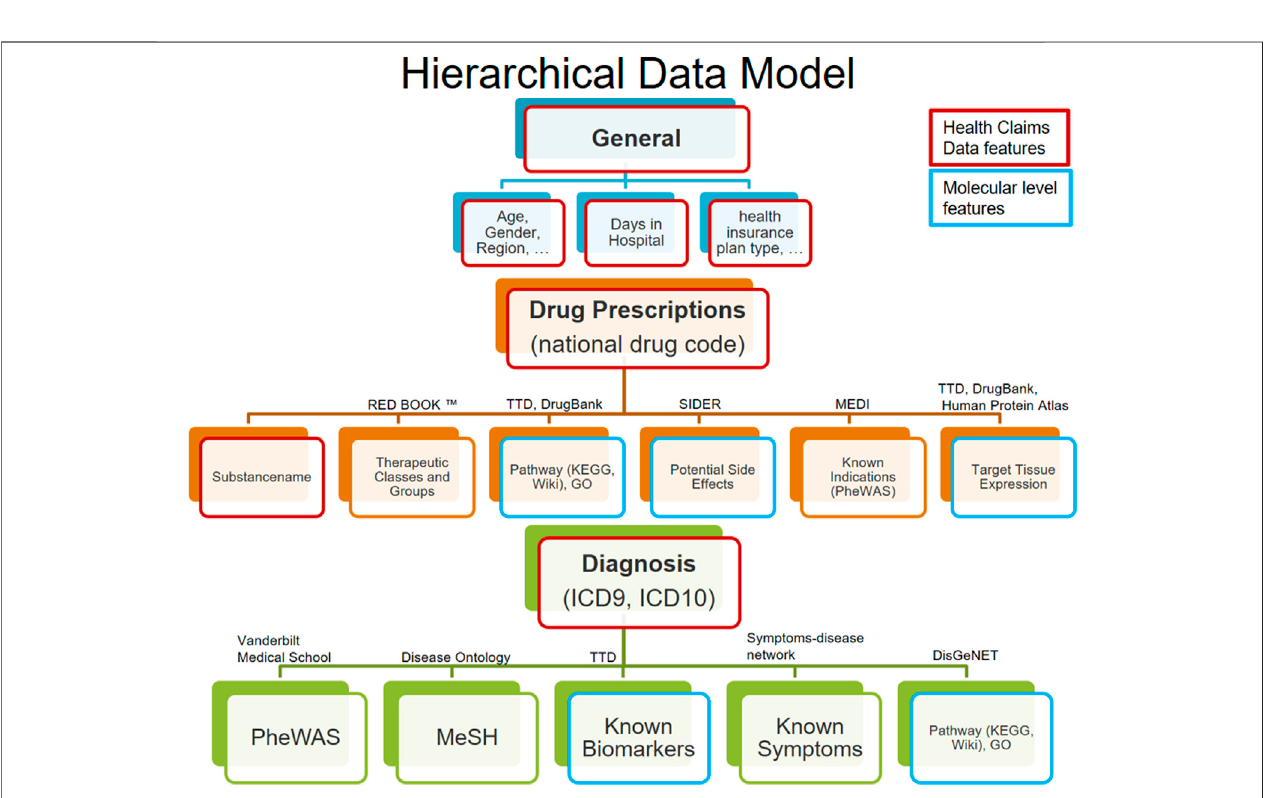
FIGURE 1 | Hierarchical data model structures the data in 3 input domains (general, drug, and diagnosis) and according subdomains. Features retrieved from the claims data are highlighted in red, and all others are augmented features (including those highlighted in blue).